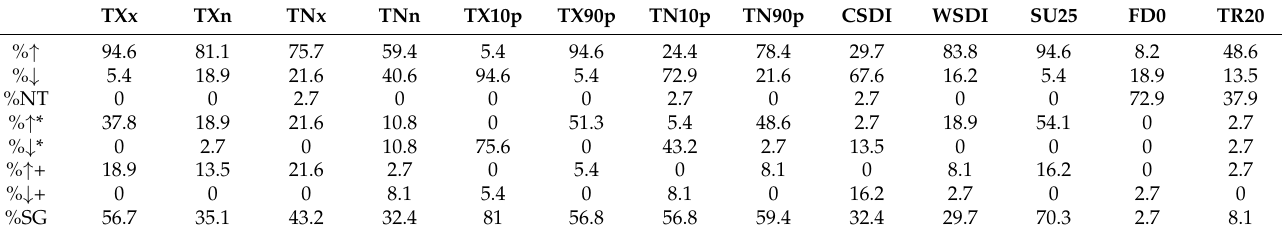
Table 7. Summary of trend results for extreme temperature indices in Ethiopia.